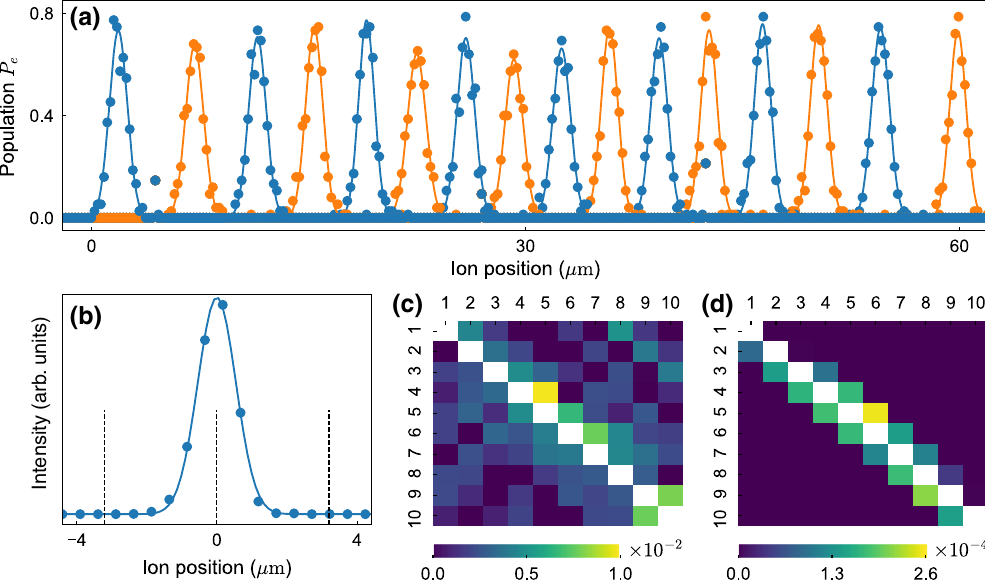
FIG. 13. AOD addressing unit performance. (a) Scan of the addressing beam over a 16-ion crystal. The population P e is used as a proxy for the signal intensity; see the main text. Solid lines are Gaussian fits to data, alternating colours for clarity. (b) Spot size measurement of the focused addressing beam at 729 nm. A single ion’s position is scanned electrostatically along the trap axis by varying the endcap voltages. The square of the Rabi frequency is plotted as a function of this position. By fitting a Gaussian distribution to the data we obtain a beam width of w 0 ≈ 1.1 μ m. Dashed black lines indicate the nearest neighbors for a 50-ion crystal at the minimal distance of approximately 3.2 μ m. (c) Resonant crosstalk measurements in a ten-ion crystal with minimal inter-ion distance of 3.5 μ m. Plotted are the ratios of Rabi frequencies of ions relative to the addressed ion (white on the diagonal). (d) Same as (c) but using off-resonant, compensating U ( 3 ) pulses; see the main text. Ions where Rabi oscillations are too slow to fit reliably are set to 0 in the plot to avoid a spurious